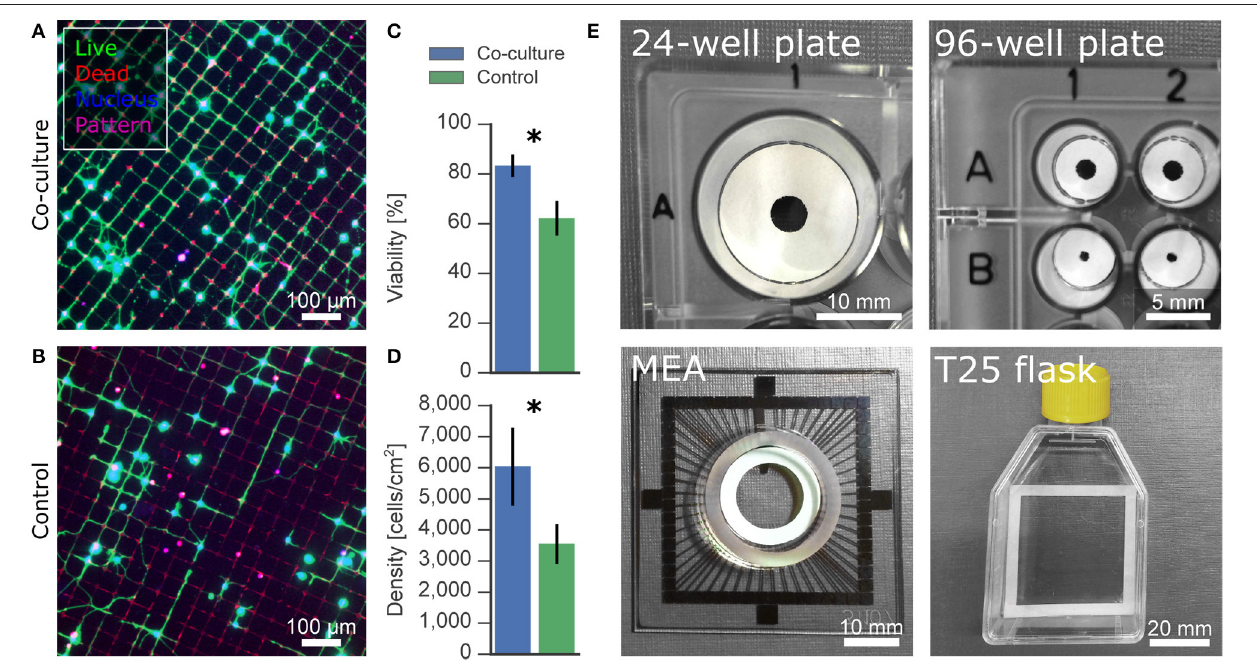
FIGURE 6 | Applications and versatility of paper-based co-culture platform. (A,B) Effect of astrocytic co-culture on low-density neurons on microcontact-printed patterns. Patterned networks often require low densities to avoid clumping of neurons on the cell-adhesive regions, resulting in low viability. (C,D) Cell viability and density was improved under co-culture condition compared to control mono-cultures. (E) Paper-based culture can be structured to fit any culture vessel, such as well plates, multielectrode arrays and flasks, for versatile applications. Significance levels: * p <